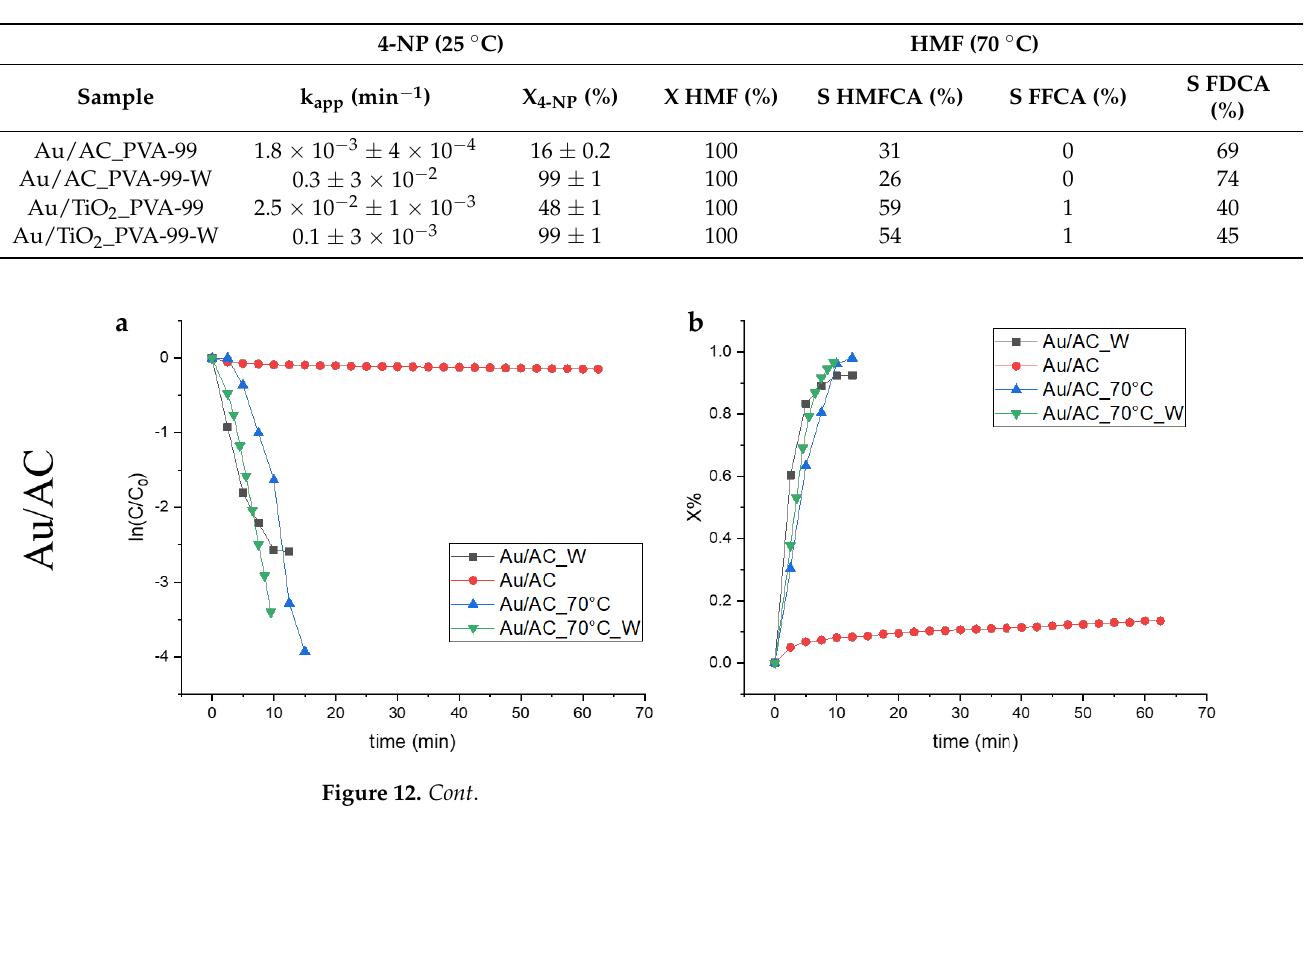
d Figure 12. Cont